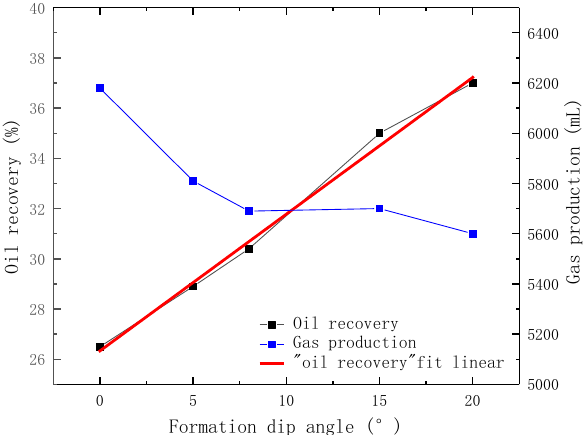
Fig. 6 The influence of back pressure on the oil recovery (experiment condition: temperature 80 °C, gas cap volume 1 PV, pressure of gas cap 1 MPa, formation dip angle